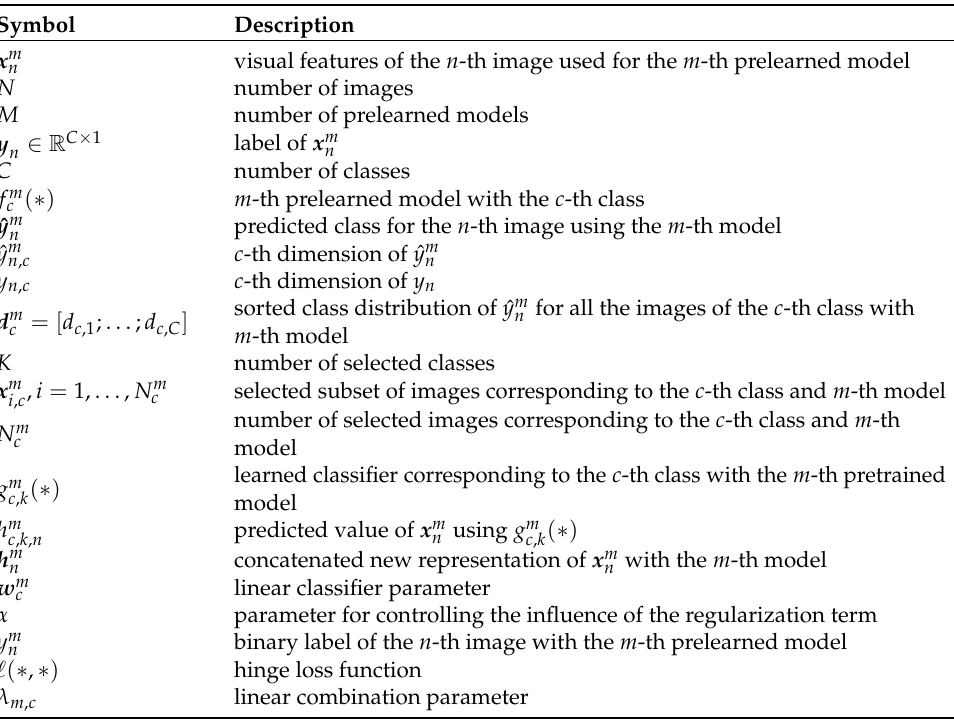
Table 1. The symbols used in this paper and their